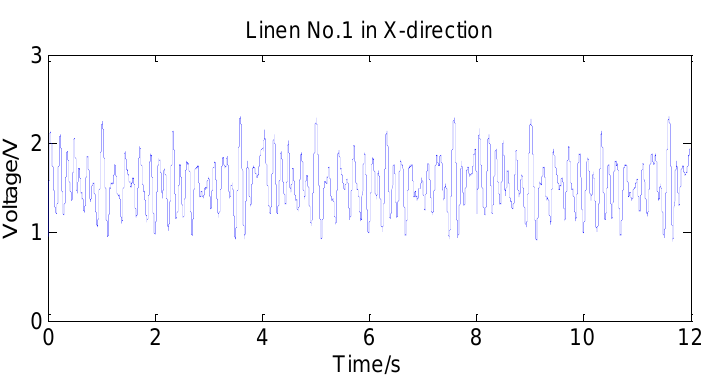
Figure 7. The raw data of linen No.1 in the time